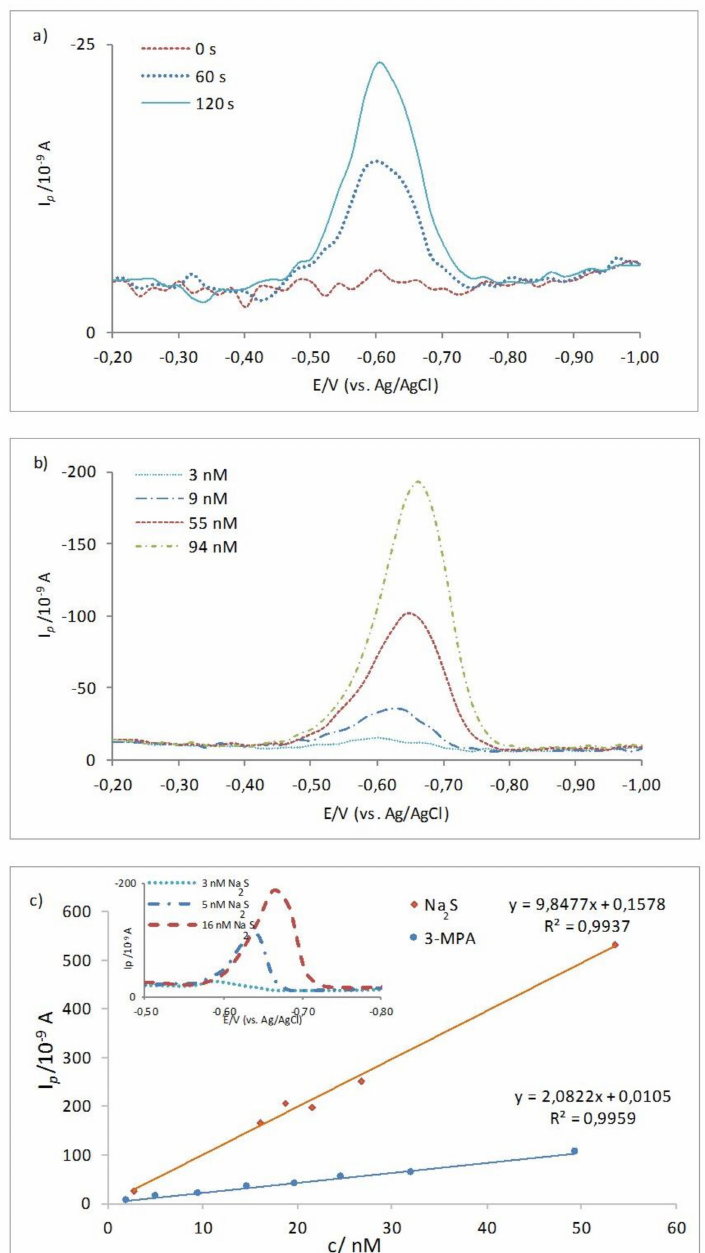
Figure 1. Cathodic striping square wave voltammetry (CSSWV) curves showing ( a ) accumulation e ff ect in 9 nM methyl 3-mercaptopropionate (3-MPA) electrolyte solution; ( b ) e ff ect of increasing concentration of the 3-MPA, and ( c ) calibration curves for the 3-MPA and Na 2 S, with insertion of CSSWV curves for increasing sulfide concentration in electrolyte solution. Experimental conditions: E d = − 0.2 V, A = 25 mV, f = 80 Hz, t = 120 a